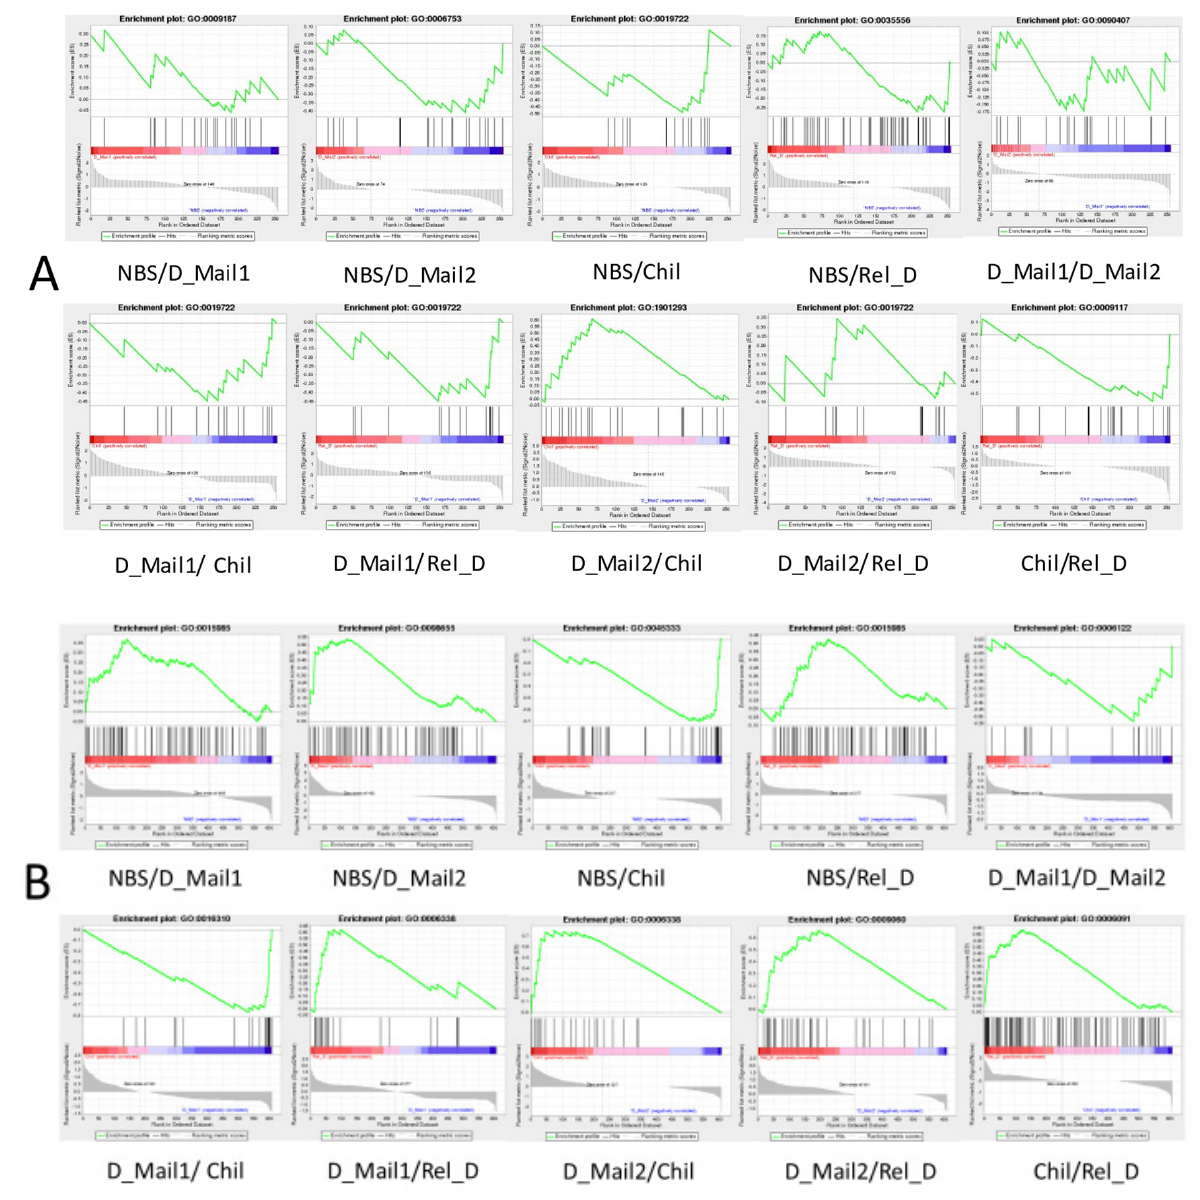
Figure 11. Gene set enrichment analysis (GSEA) ( A ) Phototransduction and Circadian rhythm genes play a role in different periods of beet webworm. ( B ) Thermogenesis gene plays a role in different stages of the beet webworm. The curve at the top represents the dynamic enrichment score (ES) value, and the highest point represents the ES value of the gene set (details of each figure are shown in Supplementary Tables S7 and S8).